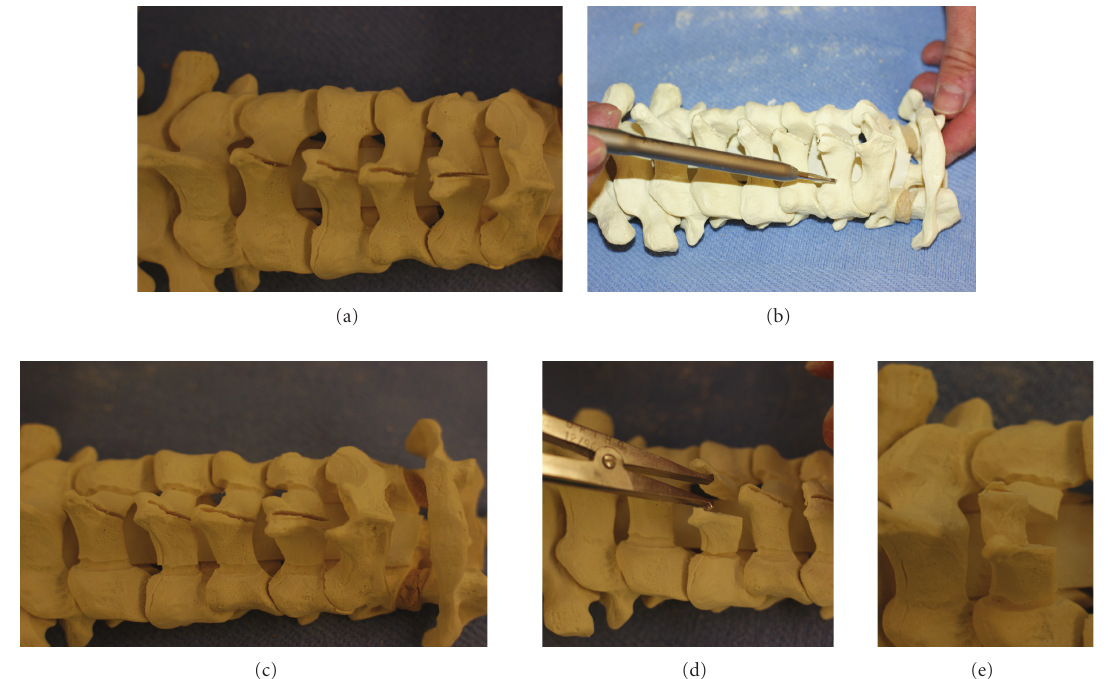
Figure 10: In the double-door laminoplasty technique, a high-speed burr is used to split the spinous processes in the midline (a). The burr is then used to create troughs bilaterally at the junction of the lamina and lateral mass, as shown in (b) and (c). The hemilaminae are separated at the midline with a laminar spreader and elevated (d). The expanded canal is then held in the open position with either bone graft or ceramic/hydroxyapatite spacers (e).